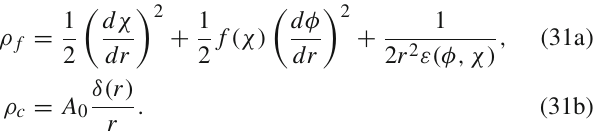
to rewrite ρ f in the